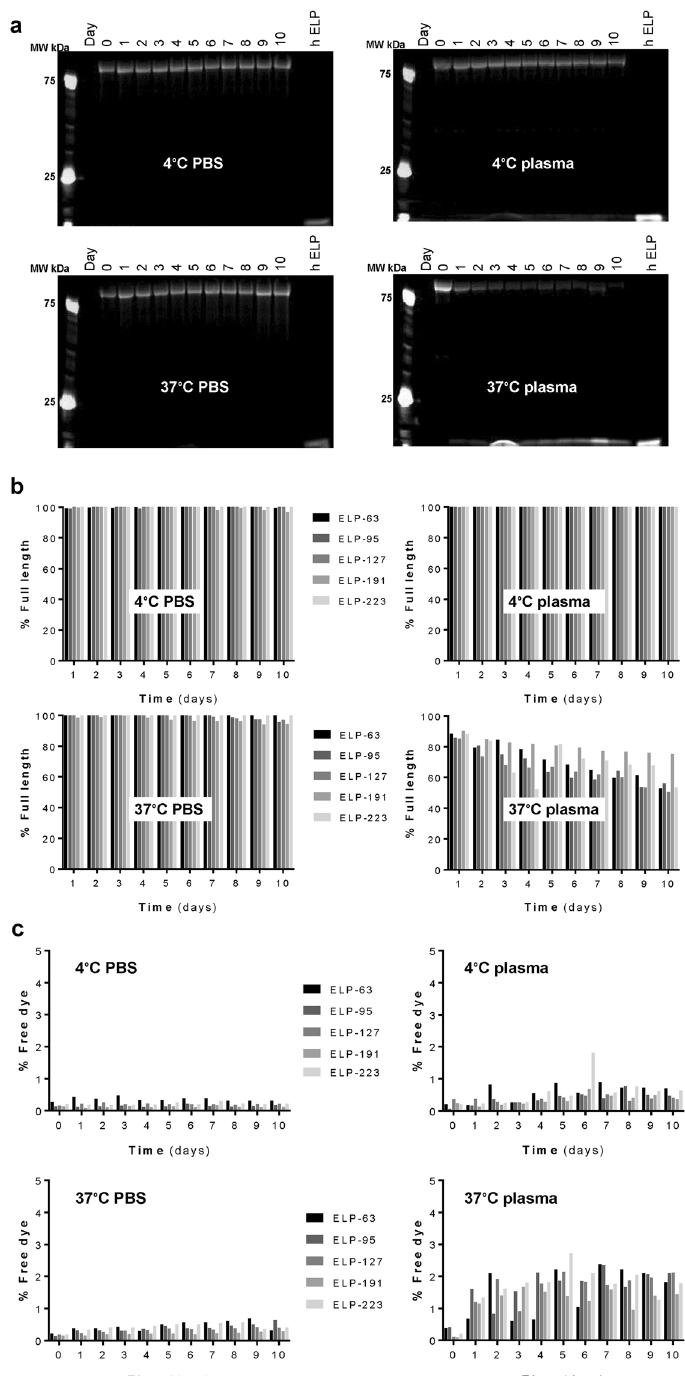
Figure 3. Stability of ELP Constructs. ( a ) Representative SDS-PAGE gel for ELP-223 (86 kDa) with hydrolyzed ELP (hELP) as a positive control, visualized by direct fluorescence imaging of the fluorescently-labeled ELP. ( b ) Polypeptide stability quantified from the SDS-PAGE analysis for all sizes of ELP proteins. ( c ) Fluorophore loss evaluated by direct fluorescence